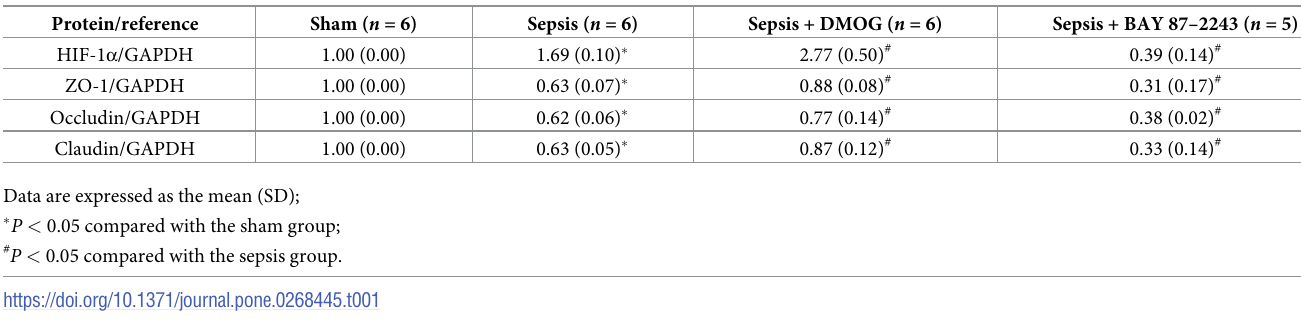
Table 1. Effects of an HIF-1 α activation/inhibition on the expression of HIF-1 α and TJ proteins in the intestinal mucosa in